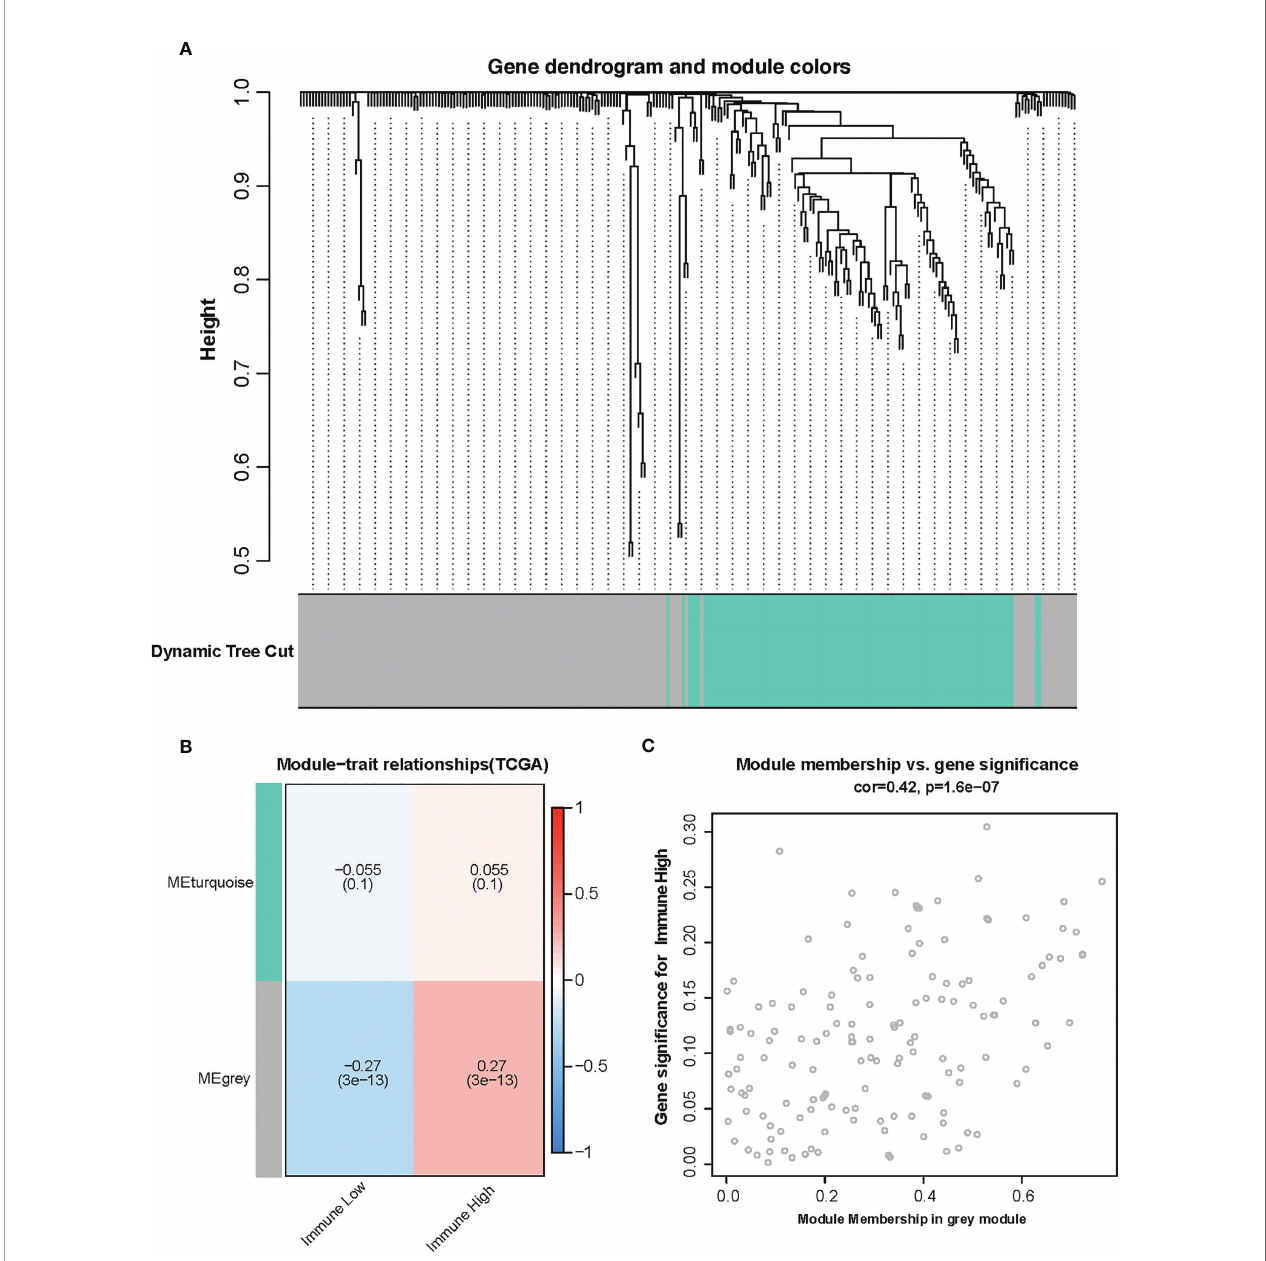
FIGURE 2 | Identi fi cation of modules associated with the immunity in the Cancer Genome Atlas glioma dataset. (A) The cluster dendrogram of co-expression network modules was ordered by a hierarchical clustering of genes based on the 1-TOM matrix. Each module was assigned different colors. (B) Module – immune relationships. Each row corresponds to a color module, and each column corresponds to immune score (high and low). (C) Module membership vs . gene signi fi cance in gray